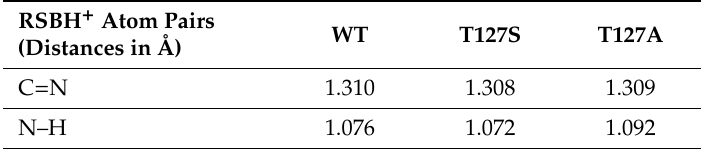
Figure 2. Optimized geometry of ( A ) Cr ChR2-WT, ( B ) T127S, and ( C ) T127A variants. The retinal Schiff base and side chains of the counterion complex are shown as grey and yellow sticks, respectively. Dotted lines correspond to the hydrogen-bonding network. Table 1. Bond length in selected RSBH + atom pairs, based on the hybrid quantum mechanics / molecular mechanics (QM / MM)-optimized geometries.